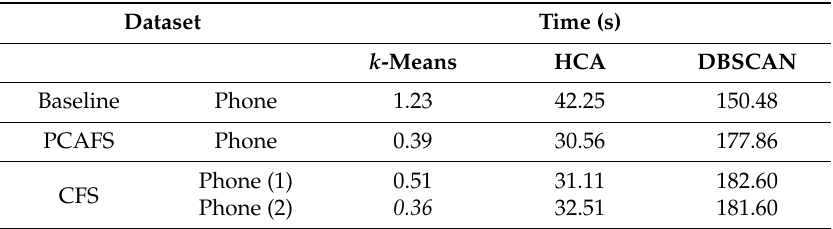
Table 5. Processing time of clustering the Phone data. HCA: hierarchical clustering analysis; DBSCAN: density-based spatial clustering of applications with noise. The bold and italic value denotes the fastest overall time that has been achieved.